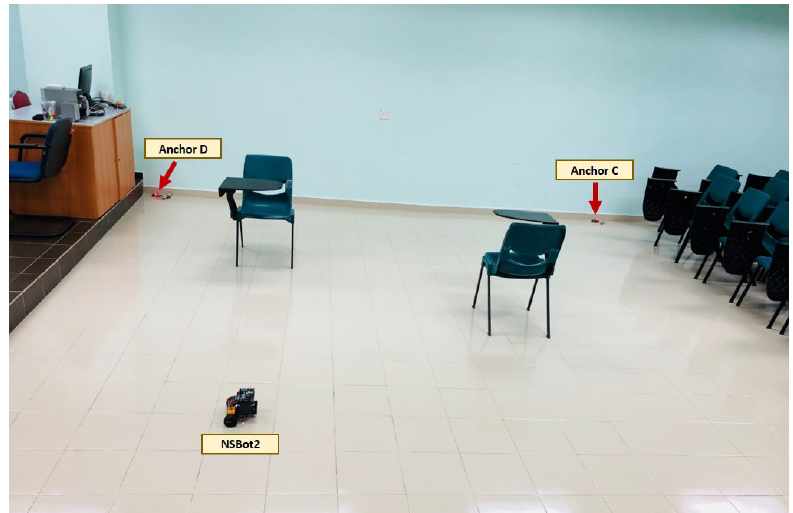
Figure 9. Overview of the experimental setup for performance evaluations. Chairs were randomly placed in the experimental